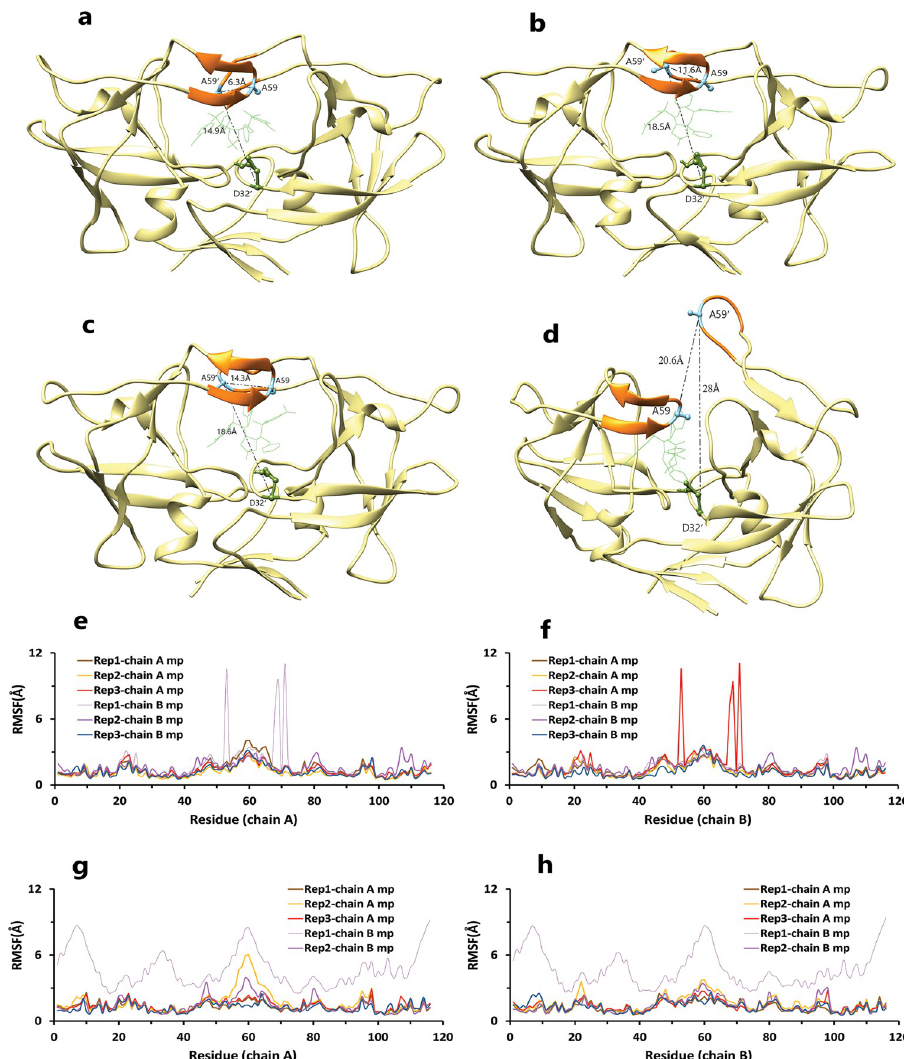
Fig 3. Different modes of the flap. A , Close form of the flap. B , Semi-open form of the flap. C , Open form of the flap. D , Wide-open form of the flap. E , F , RMSF values of HTLV-1 protease in the 4YDG PDB code, during simulations. G , H , RMSF values of HTLV-1 protease in the 4YDF PDB code during